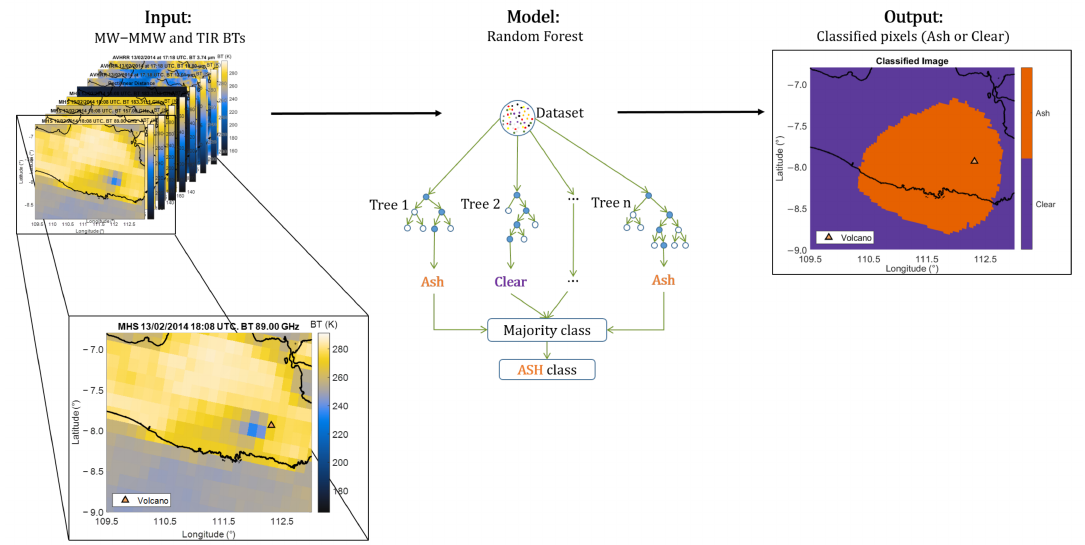
Figure 1. Scheme of the classification methodology. ( Left ) The spectral signatures at different frequencies and wavelengths. ( Middle ) The representation of the RF model. The dataset represents all the available pixel information (i.e., the images in the Left panel ). The blue circles in the trees represent the decision-making paths for each pixel that end with a classification (i.e., ash or clear pixel). In the majority class box, the most frequent class is chosen among all the trees predictions. ( Right ) The output binary mask, where values of 1 (orange pixels) represent tephra pixels and values of 0 (purple pixels) represent clear (no tephra-contaminated)